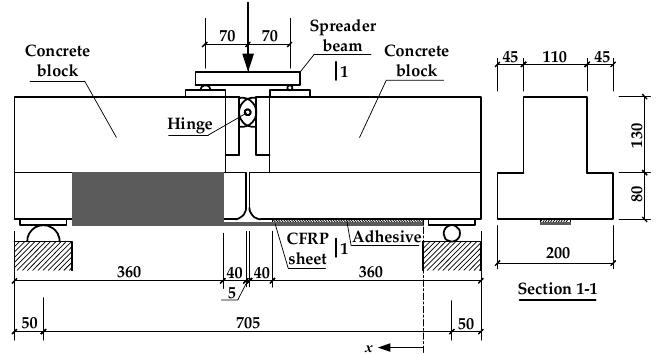
Figure 1. Schematic of the test setup (unit: mm).